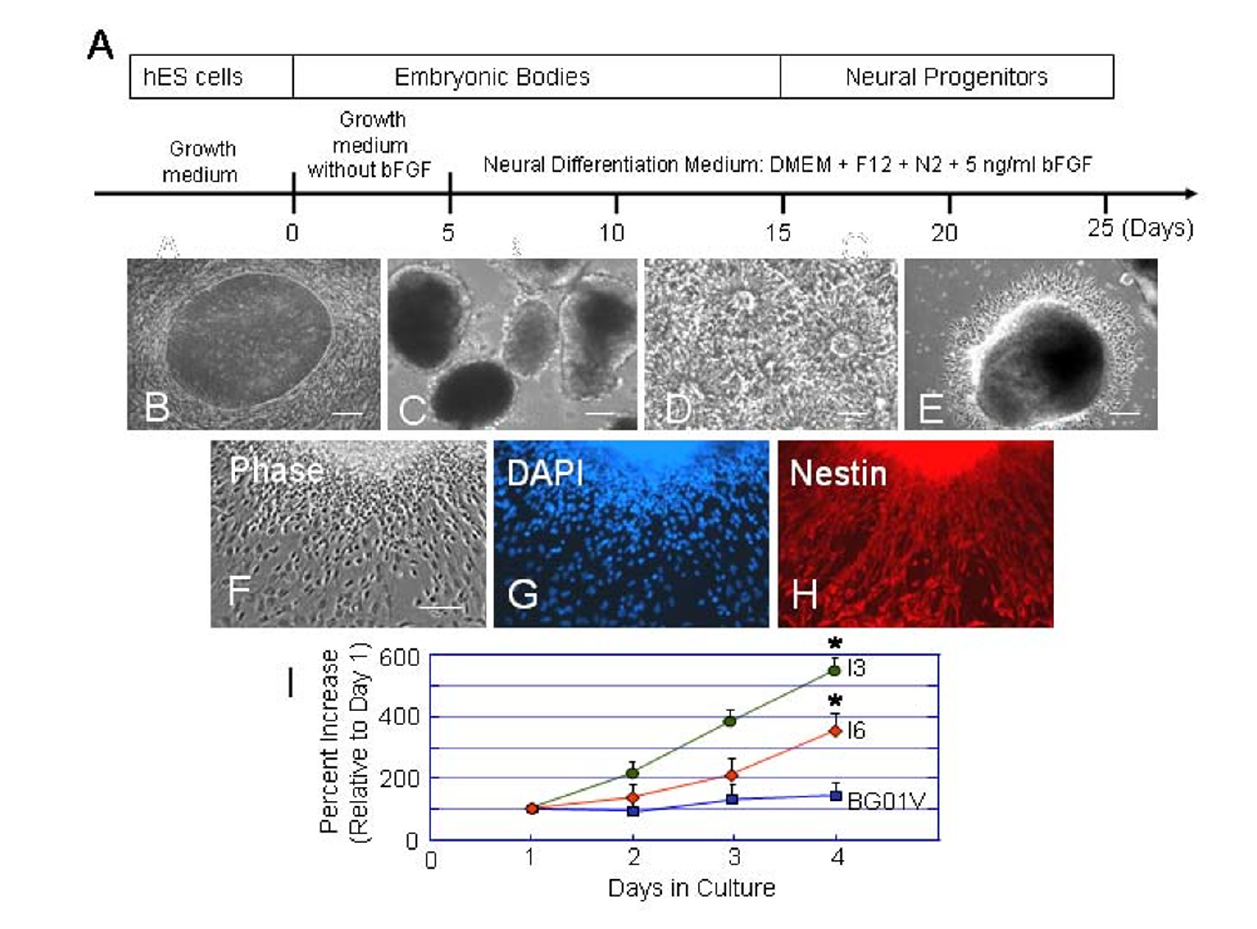
Figure 8 The comparison of the neural progenitor derivation from the I3, I6 and BG01V hESC lines over time under the same neural differentiation-promoting condition . (A) The protocol used to direct hESCs into neural cell lineages. (B-E) Phase contrast images show the progression of the neural induction of hESCs in which the hESC colonies (B) were removed from the MEF feeders and grown into floating aggregates or embryoid bodies (EBs) (C). Neural rosettes (D) were induced by the neural differentiation medium. New cells constantly generated and migrated radially away from the center of the EB and formed a rim of cells (E). Bars in B-E = 100 μ m. (F-H) Neural progenitors derived from the I3 cell line. Phase contrast image of I3-differentiated cells (F) were immunostained for nestin (H) and nuclear counterstained with DAPI (G). (I) The plot shows sig- nificant differences in the average percent increase in the number of nestin+ cells differentiated from the three cell lines. Values are expressed as percent increase in Nestin+ neural progenitors (mean ± SEM). Statistical analysis shows that the percent increase in number of Nestin+ cells generated from the I3 or I6 cells is significantly greater than that generated from BG01V cells, * p < 0.05. Bar in upper panel = 200 μ